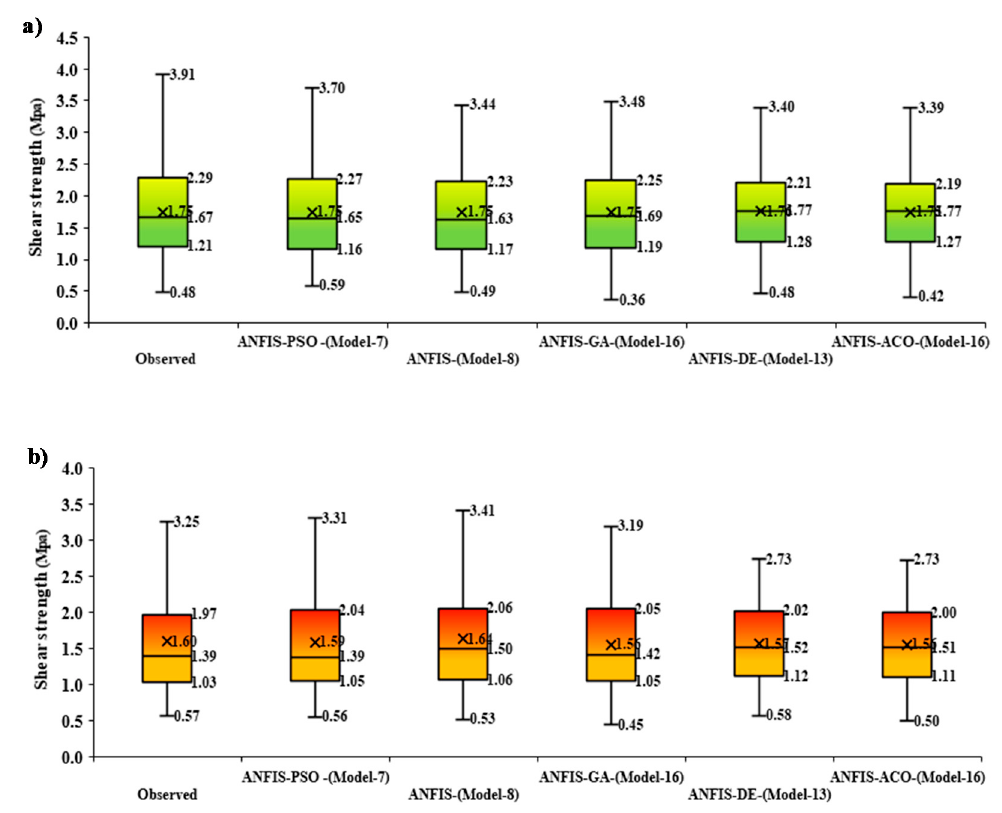
Figure 5. Boxplot of computed shear strength against predicted ones ( a ) Training stage and ( b ) Testing stage.